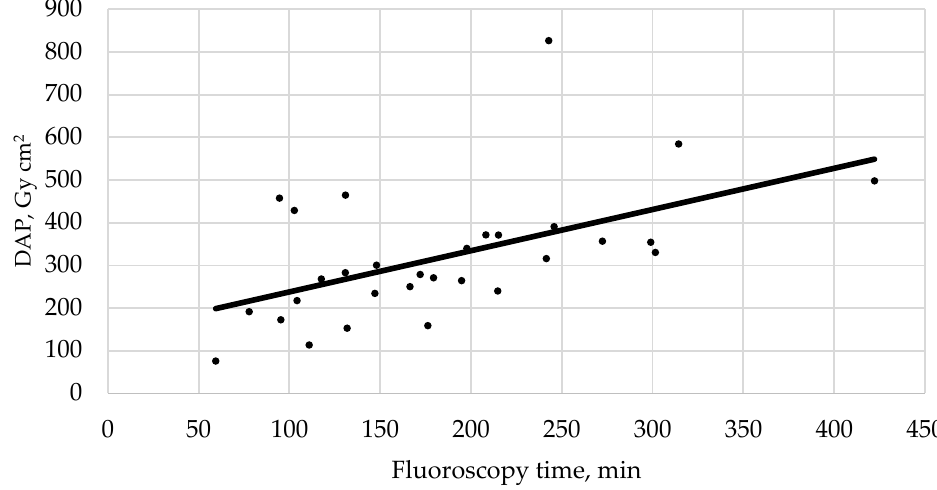
Figure 2. The relationship between fluoroscopy time and radiation exposure is summarized by the fitted regression line. Table 4. Comparison of dosimetric data and number of implanted coils between treatment groups with different DSA